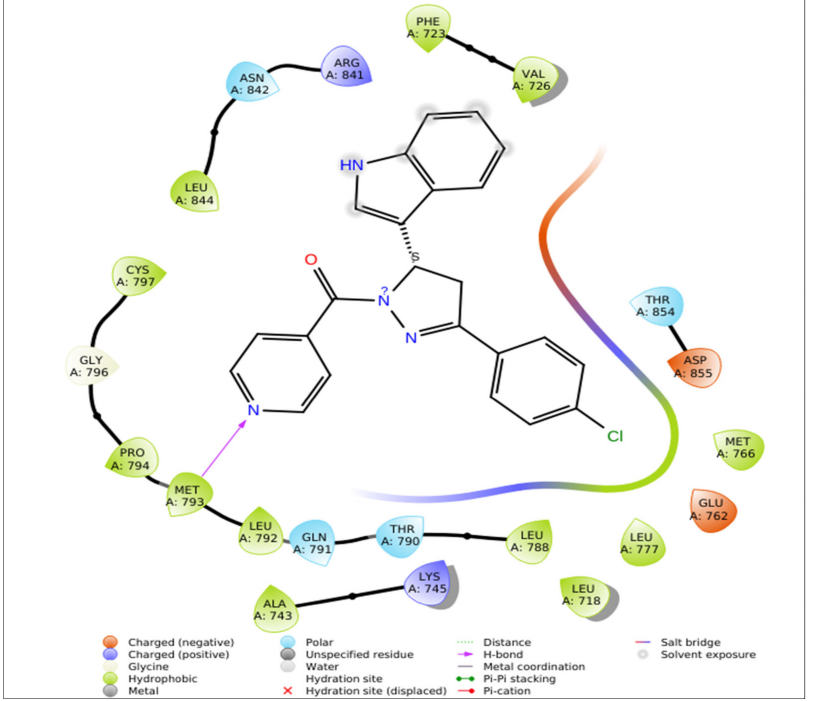
Figure 4. Ligand binding: 2D overlay of the compound HD12 with the active site amino acids of the